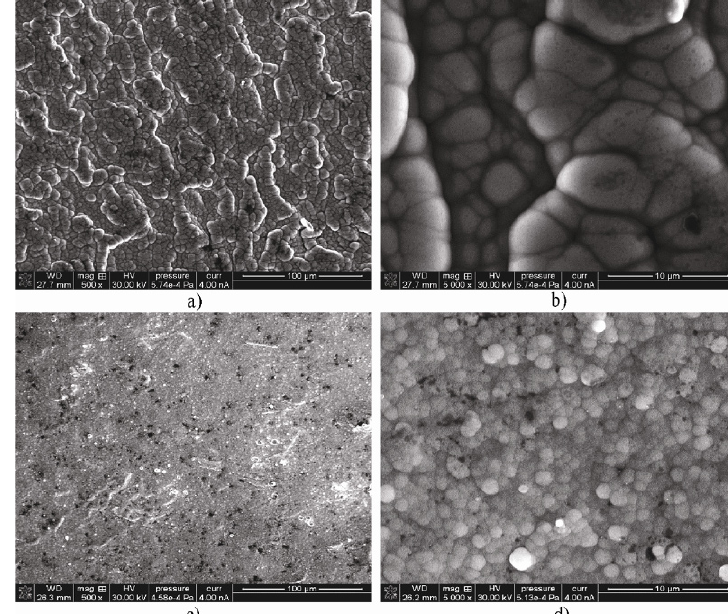
Figure 7. SEM images of: a-b) ZNP(5); c-d) ZNP(6).